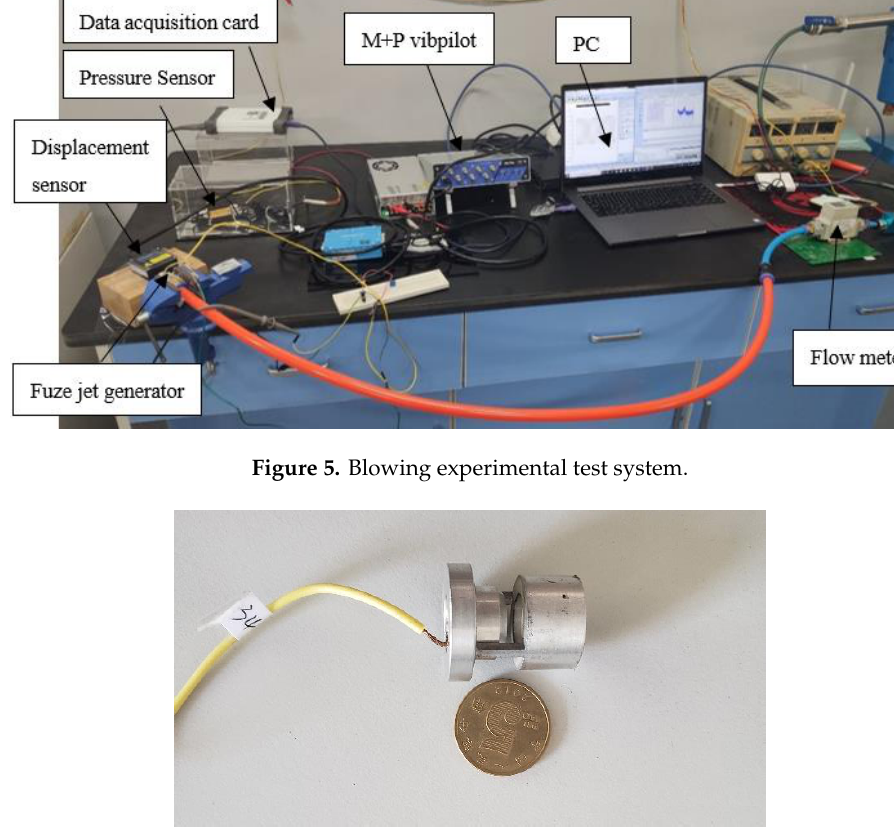
Figure 6. Physical picture of prototype #1.